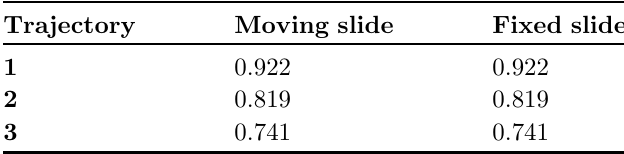
Table 6. MMA values obtained from the dynamic programming algorithm moving the slide and from the heuristics by fi xing the slide